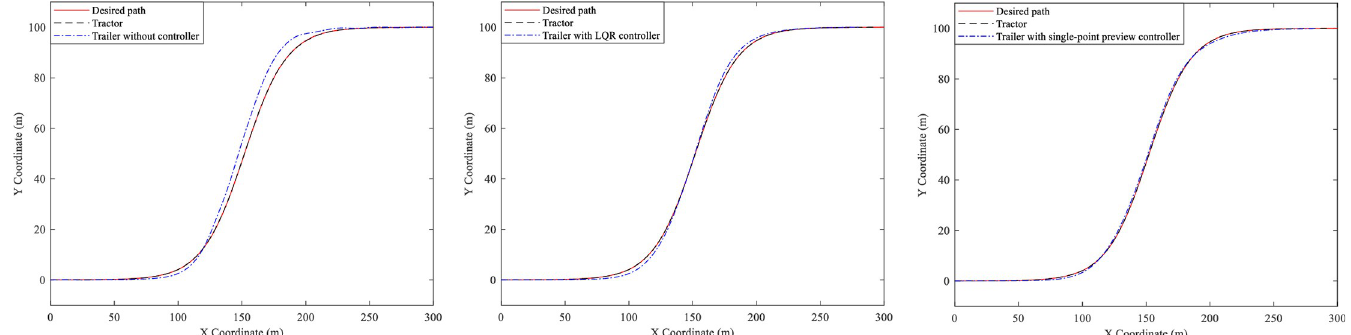
Fig 6. Trajectory curves. (A) Trailer without controller. (B) Trailer with LQR controller. (C) Trailer with single-point preview controller.